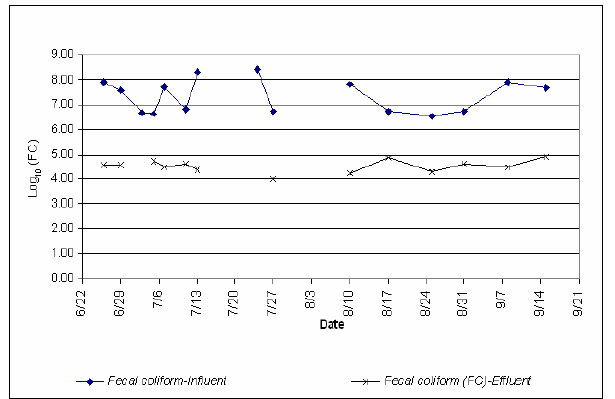
Figure 2 : Fecal coliforms result for influent, effluent of oxidation ditch